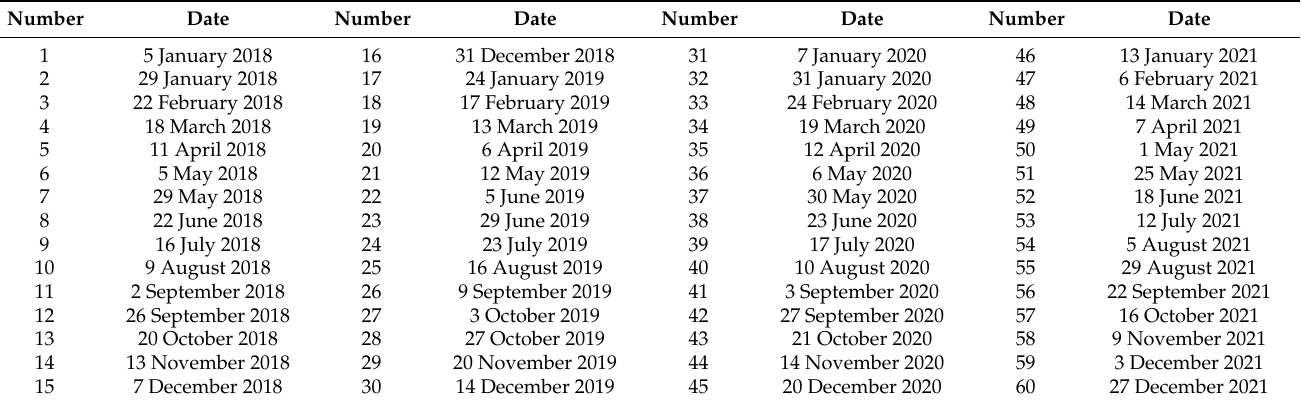
Table 1. Acquisition time of SAR data.